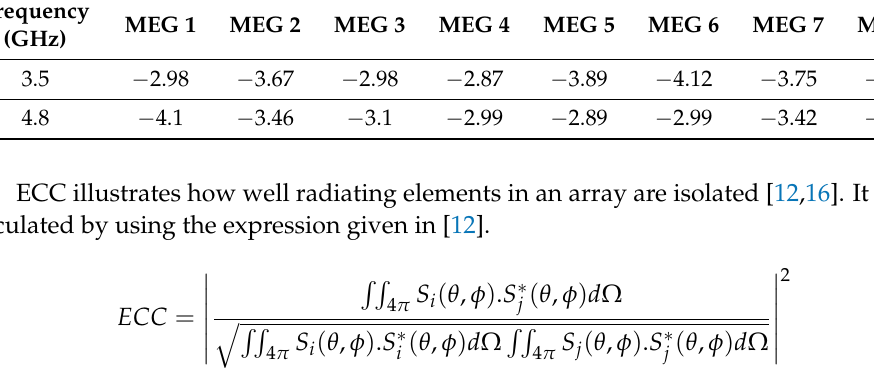
Table 1. Computed MEGs of 8-element MIMO